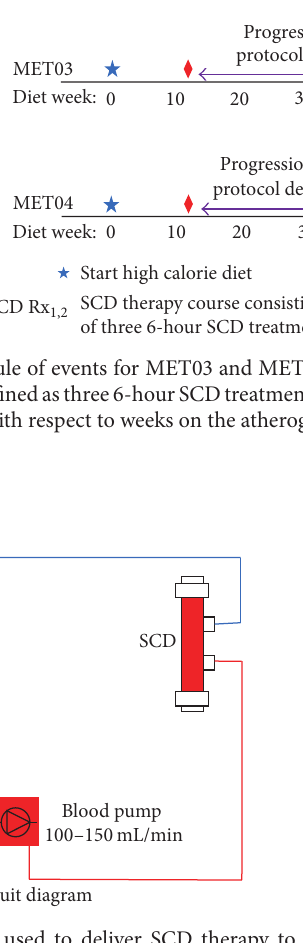
Figure 2: Extracorporeal circuit used to deliver SCD therapy to Ossabaw swine with induced metabolic